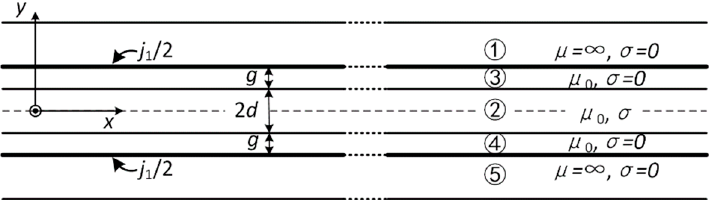
Figure 5. Quasi-2D analytical model of DLIM.